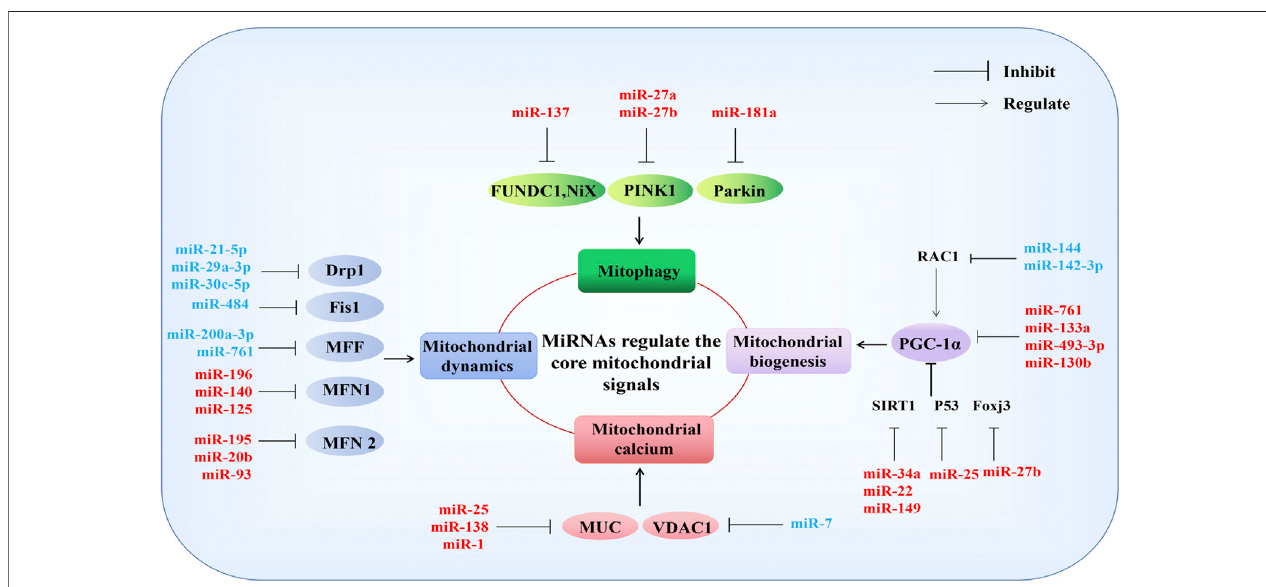
FIGURE 3 | MiRNAs regulate the core mitochondrial signals. MiRNAs participate in mitochondrial function by regulating genes directly related to mitophagy, mitochondrial dynamics, mitochondrial calcium, and mitochondrial biogenesis. Mitochondrial function-related genes: mitophagy ( FUNDC1 , NiX , PINK1 , Parkin ); mitochondrial dynamics ( Drp1 , Fis1 , MFF , MFN1 , MFN2 ); mitochondrial calcium ( MUC , VDAC1 ), mitochondrial biogenesis ( PGC-1 α ).See text for detailed explanations. Red and blue represent negative and positive regulation of mitochondrial function, respectively. T represents inhibitory effect, and arrows represent involvement in